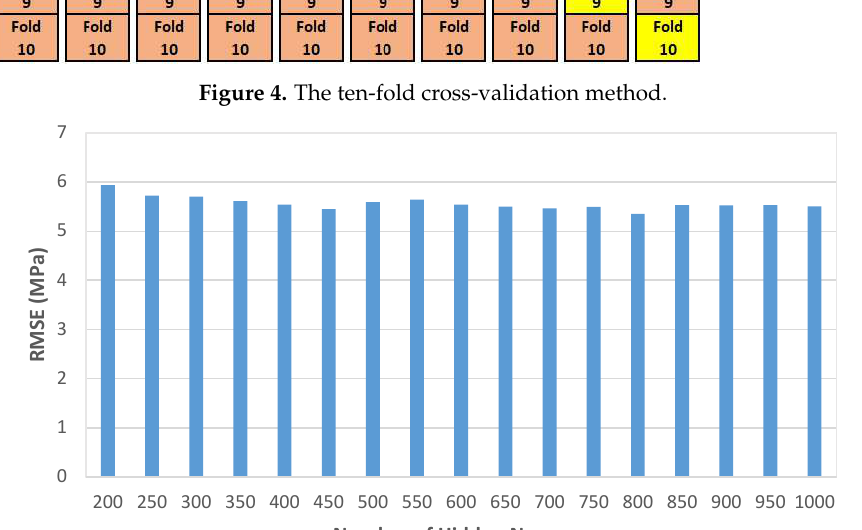
Figure 5. Average root mean squared error (RMSE) values of the RELM method with different network architectures.